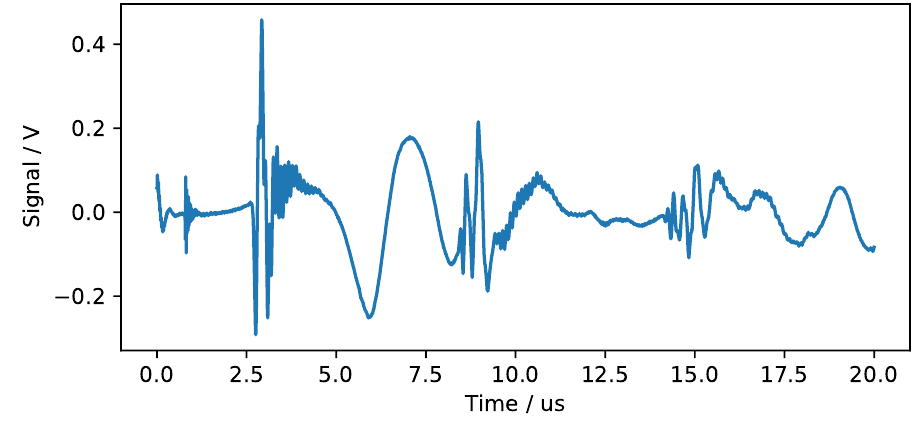
Figure 4. Typical signal received at the sensor for a pulse excitation at the opposite